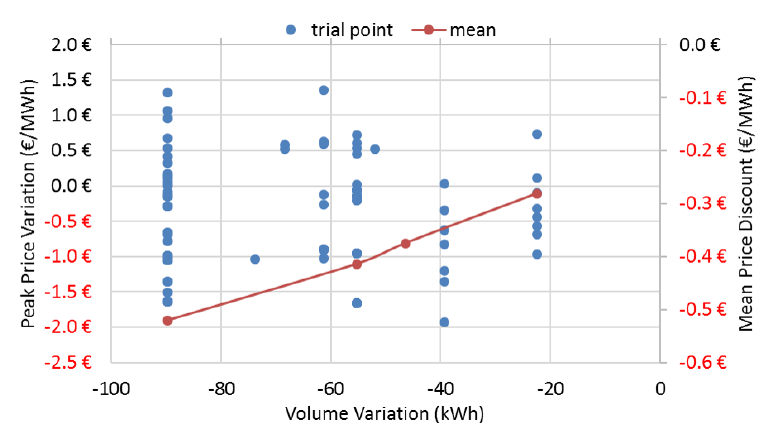
Figure 5. Retailer response to the consumption variation of the consumer in the peak